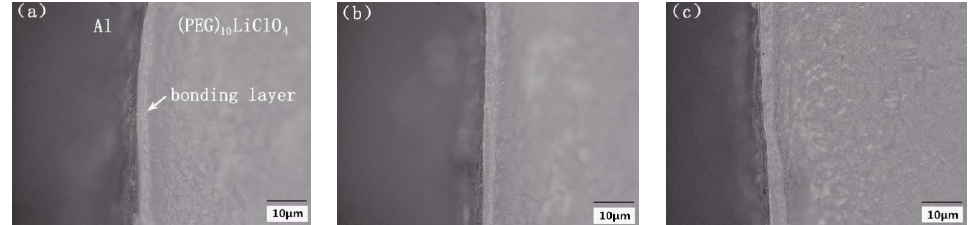
Figure 9. The image of (PEG) 10 LiClO 4 after breakdown.